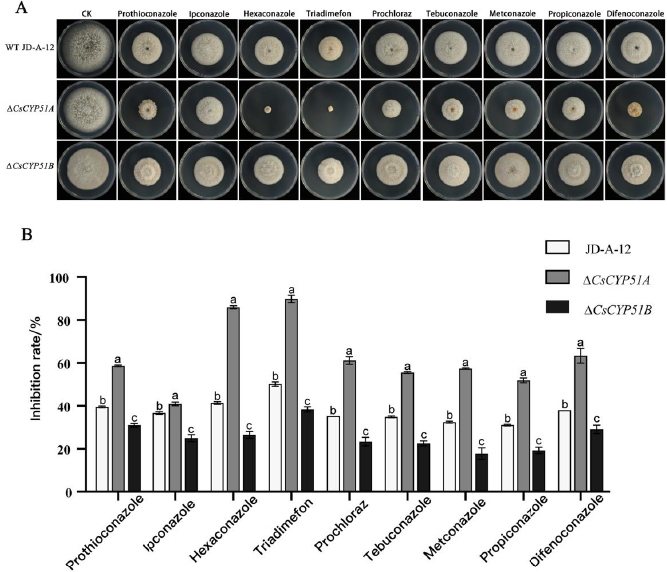
Figure 6. Using the EC 50 value as concentration to determine sensitivities of wide type JD-A-12, CsCYP51A and CsCYP51B deletion mutants to nine DMI fungicides. ( A ) The mycelium growth on a PDA plate. ( B ) Inhibition rate of nine DMI fungicides to CsCYP51A and CsCYP51B deletion mu- tants. Values with the same letters were not statistically different ( p > 0.05) according to the least significant difference (LSD) Test. difference (LSD)